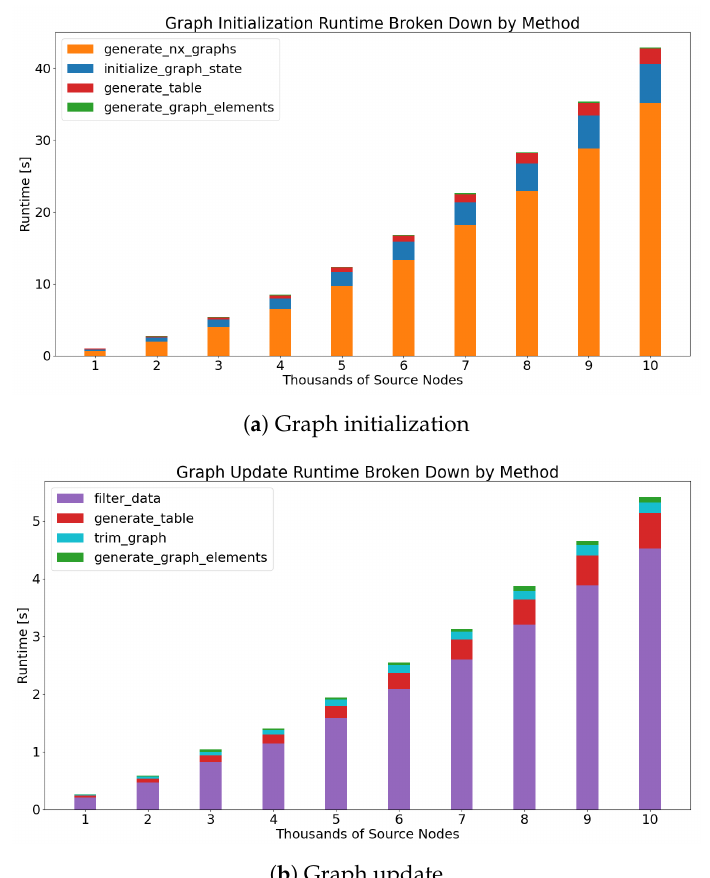
Figure 10. Runtime analysis of graph startup and update, broken down by most important methods.